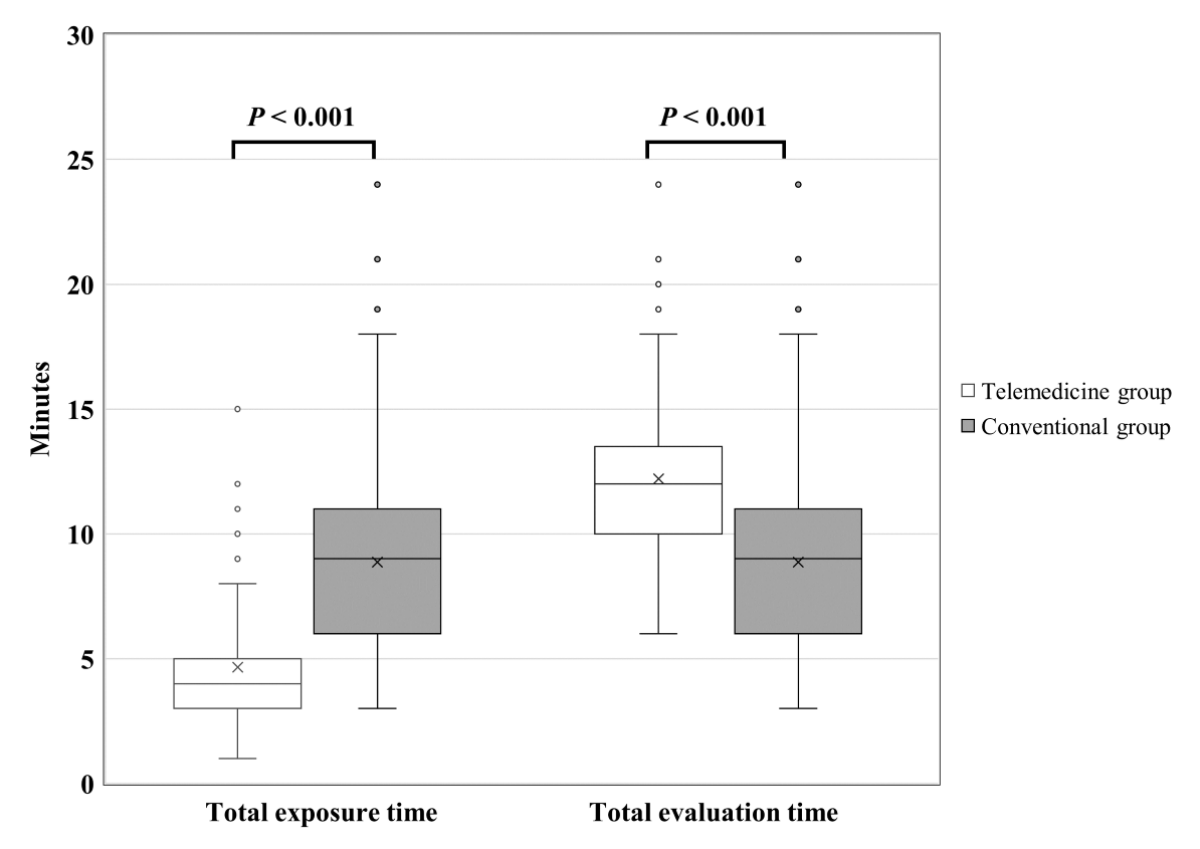
Figure 3. Box plot of the differences in the total exposure time and the total evaluation time between the telemedicine and conventional groups.